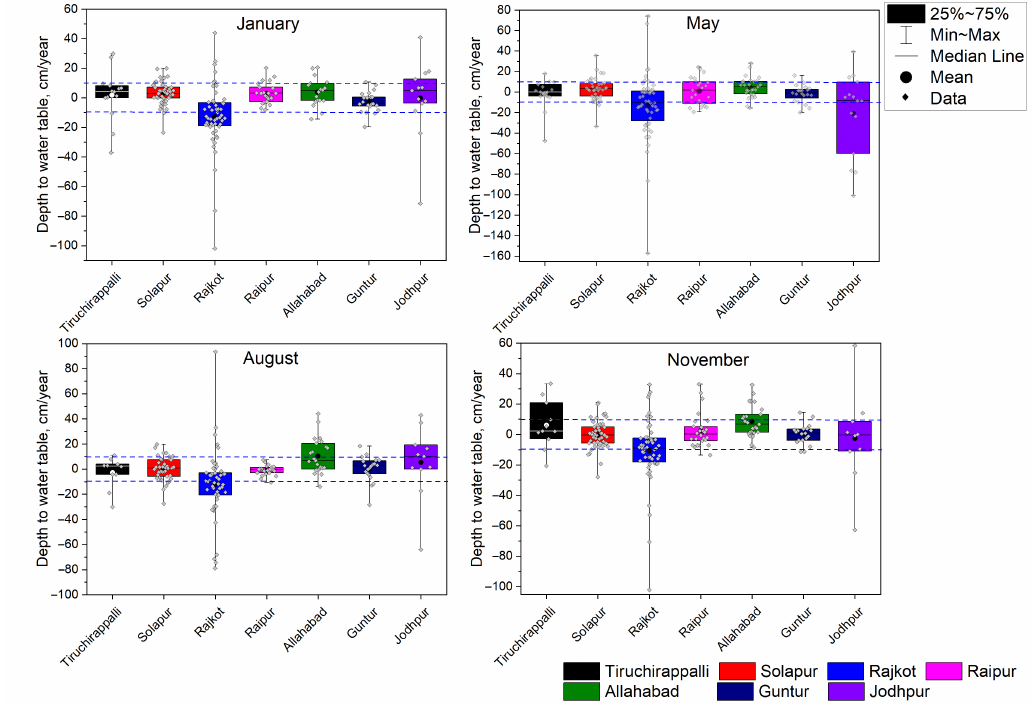
Figure 2. City-wise seasonal groundwater level (GWL) trends based on the Theil-Sen slope. A positive slope represents increasing depth to the groundwater table in cm / year, which implies decreasing GWL and vice versa. In the selected cities, GWLs were majorly varying between ± 10 cm / year. Relatively, May has better GWL trends, and at the city level, Rajkot has high increasing GWL